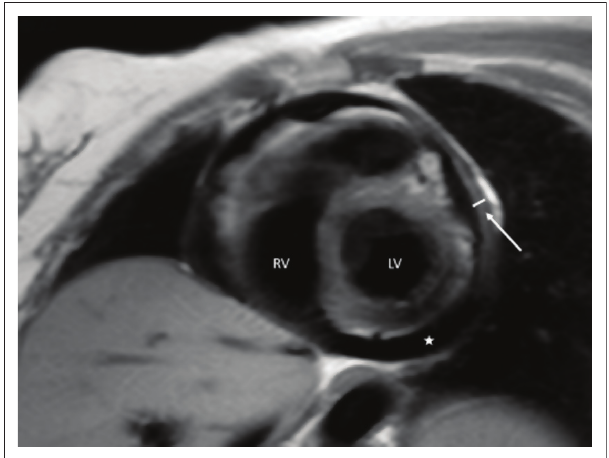
RV, right ventricle; LV, left ventricle. FIGURE 3: A 54-year-old woman with biopsy-proven cutaneous sarcoidosis. The black blood image in a short-axis orientation demonstrates a small pericardial effusion ( * ) as well as thickening (white arrow) of the pericardium, with the pericardium measuring 4 mm.